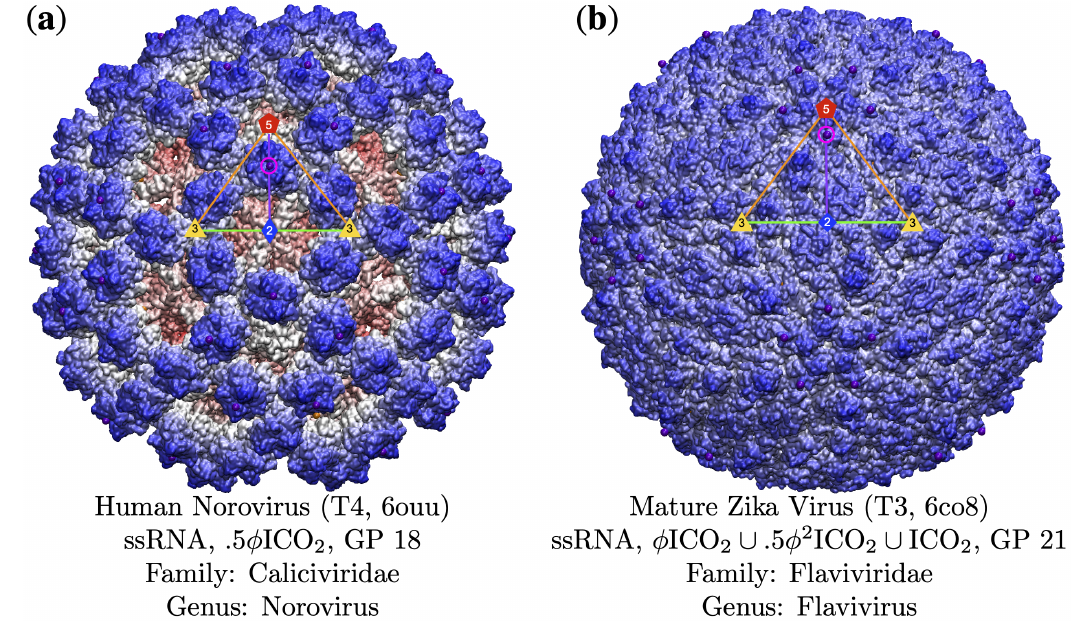
Figure 12. Gauge points 18 to 21. ( a ) Human Norovirus [59] is a T4 capsid with two protruding features; however, only the protrusion at GP 18 has an associated point array that fits the capsid well. ( b ) The Mature Zika Virus [60] has the some of the least differentiated protrusions out of all the viruses in our database. We initially identified protrusions at GP 1, 3, 8, 10, and 21. However, only the point arrays with gauge point 21 shown above had low RMSD scores (1.6Å with GP 21 arrays vs. 3.2Å with GP 8